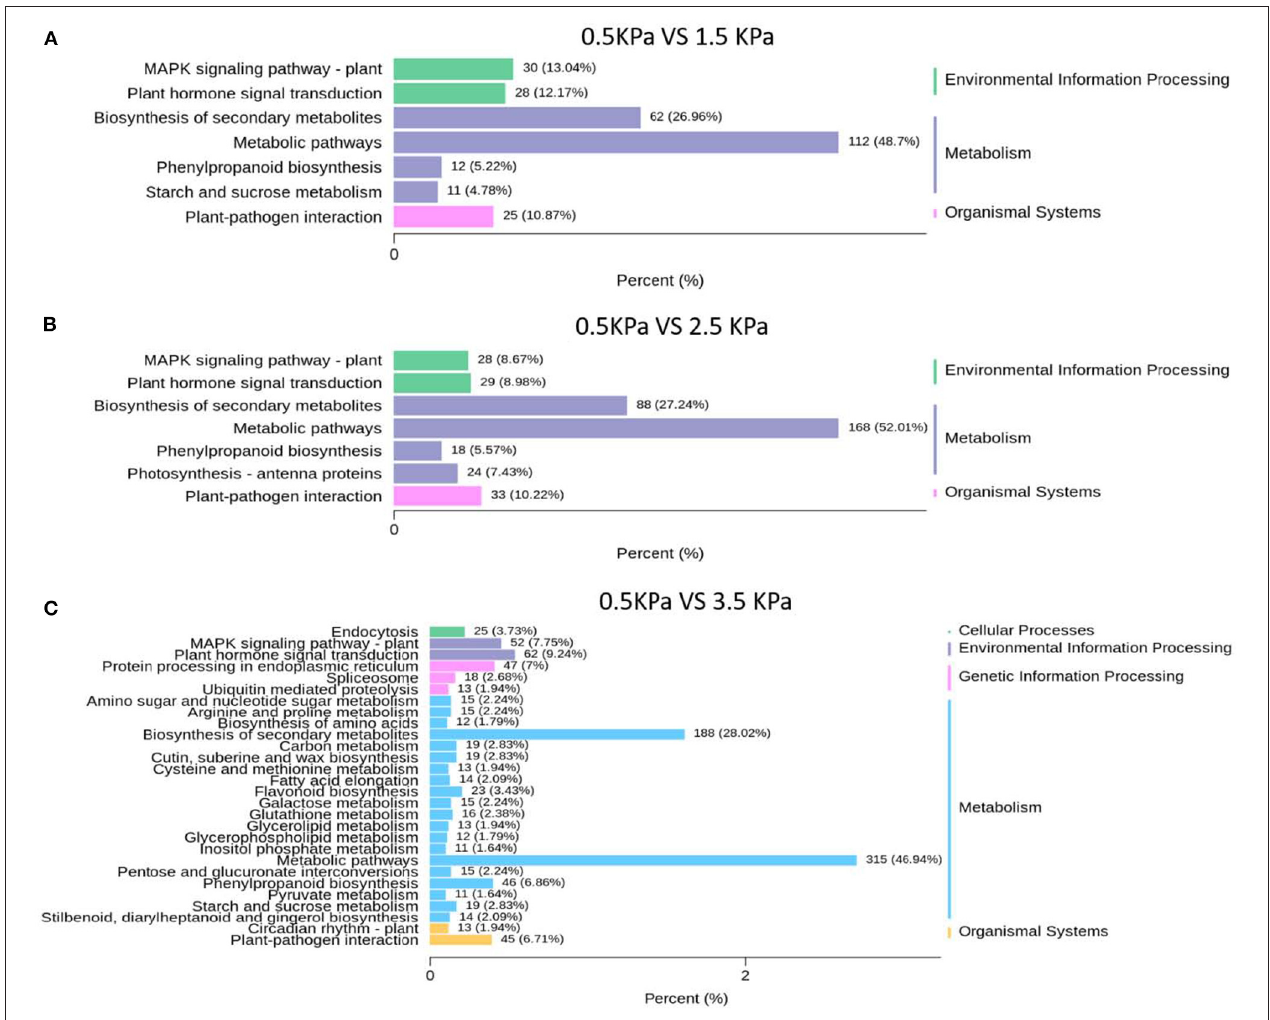
FIGURE 7 | KEGG classification analysis of differentially expressed genes under different VPD conditions: (A) 0.5kPa versus 1.5kPa; (B) 0.5kPa versus 2.5kPa; and (C) 0.5kPa versus